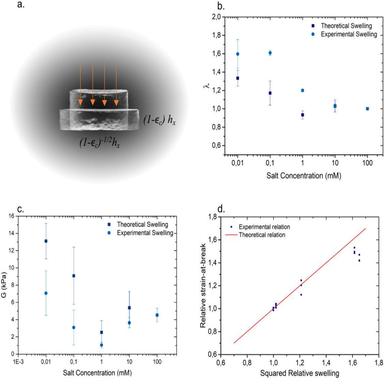
(a.) Schematic representation of the isochoric-deformation (constant volume) of the C-x hydrogel networks with width hx before compression. (b.) Comparison between experimental swelling and model predictions (0.01 mM represents swelling in MilliQ water). (c.). Shear modulus calculated from experimental swelling and predicted swelling (0.01 mM represents swelling in MilliQ water). (d) Comparison of experimental and theoretical relations between strain at break and relative swelling.